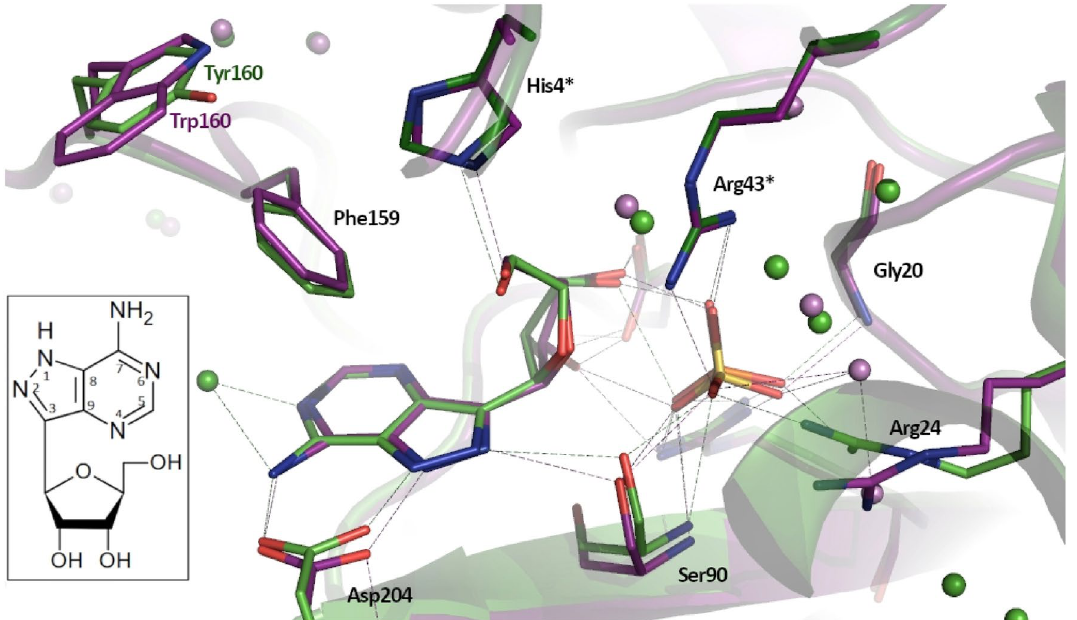
Figure 2. Comparison of active sites of the Y160W mutant (PDB 6XZ2, violet) and the WT PNP (PDB 4TS3 19 , green) complexed with formycin A and sulfate. Aminoacids forming the active site and the network of hydrogen bonds are shown. The residues His4 and Arg43 belonging to the neighbouring subunit in a dimer are marked with *. Inset: Formycin A, a structural analogue of adenosine, the natural E. coli PNP substrate. Due to the C–C glycosidic bond, that links the base and the pentose, formycin A is not a substrate for PNP, but an inhibitor, competitive vs. the nucleoside substrate. Note the difference in the base ring numbering when compared with the purine ring